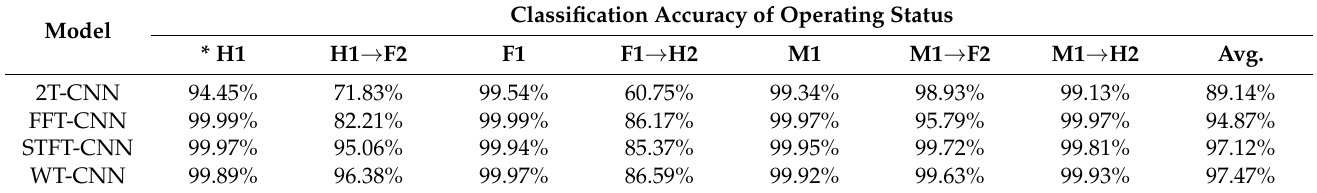
Table 7. Comparison of Different Signal Processing Accuracy.